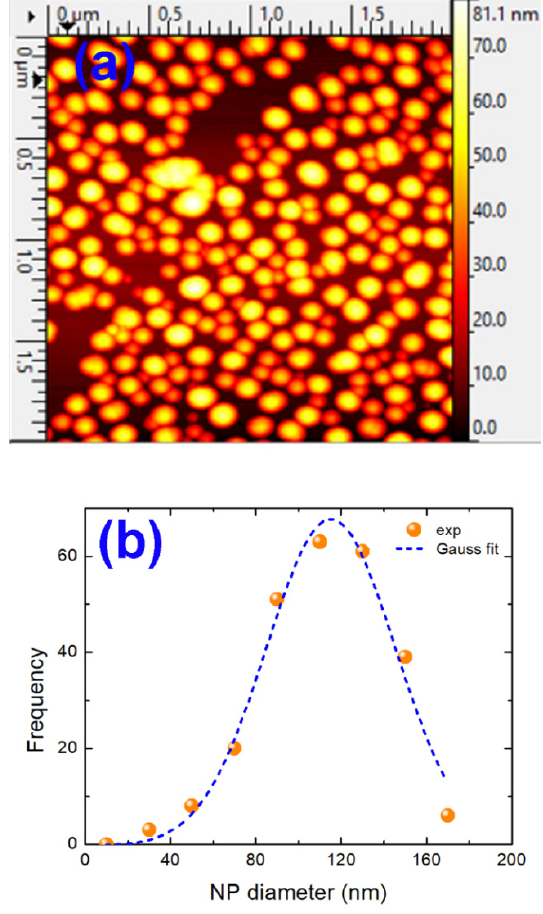
Figure 4. ( a ) AFM image of the surface of the annealed film of Figure 3 (trilayer). The image shows NPs with a diameter slightly larger than 100 nm. ( b ) The relevant diameter size distribution.